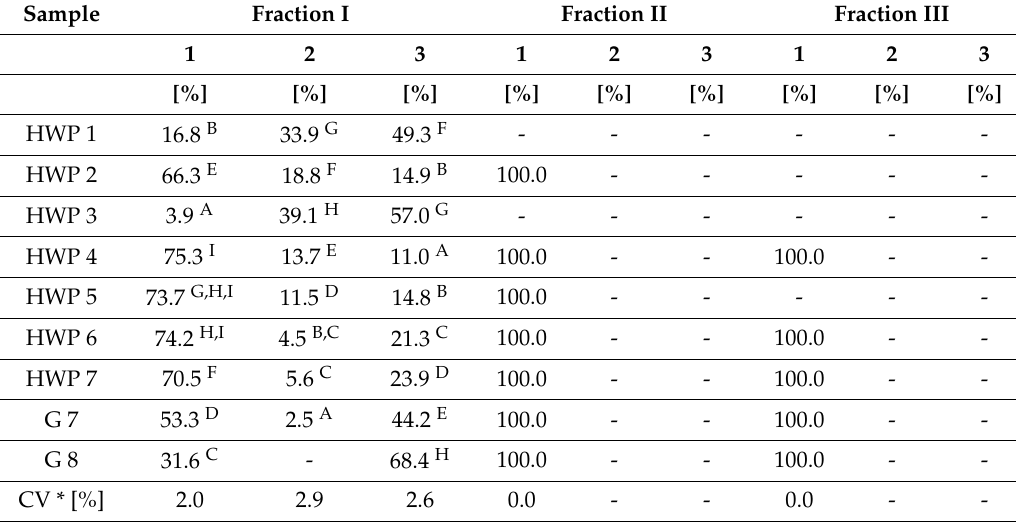
Table 3. Gel-permeation HPLC (system II): Analysis of fractions I, II, and III of treated gluten (G7 and G8) and hydrolyzed wheat proteins (HWP1-HWP7) according to their relative molecular mass distribution. Areas within each fraction were set by marker substances. 1: ≥ 14 kDa; 2: 14–2 kDa; 3: < 2 kDa. Values are given as means ( n = 3) and di ff erent capital letters indicate significant di ff erences between the samples in each column (one-way ANOVA, Tukey’s post hoc test, p < 0.05). “-” integration not possible, because the area under the curve was not di ff erent to